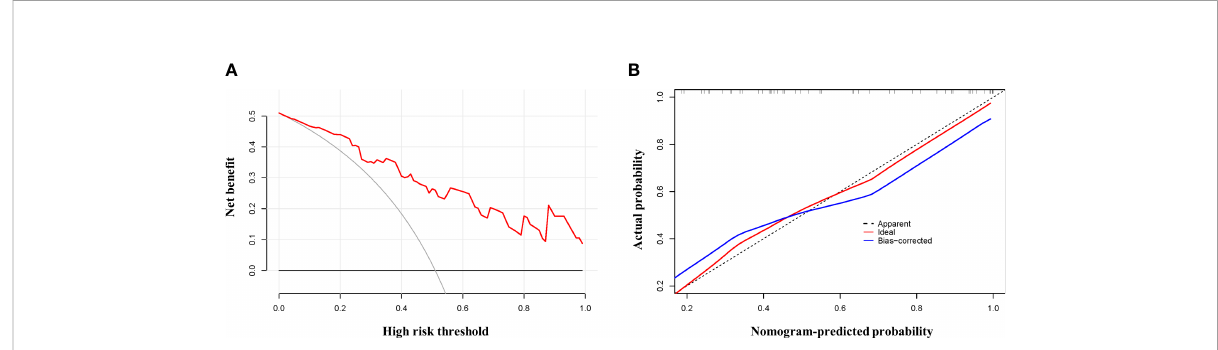
FIGURE 5 Testifying the net bene fi t and fi tting of the nomogram. Calibration and decision curve analysis was used to determine the goodness of fi t and net bene fi t of the nomogram, respectively. (A) Calibration plot of the nomogram. (B) DCA curve of the nomogram.